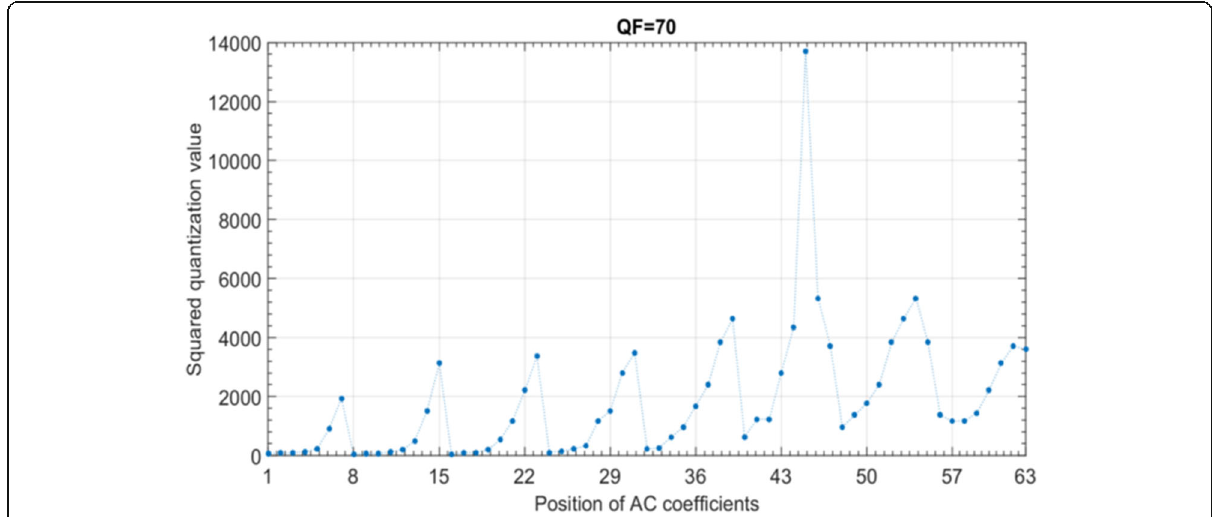
Fig. 4 Squared quantization entries for each position